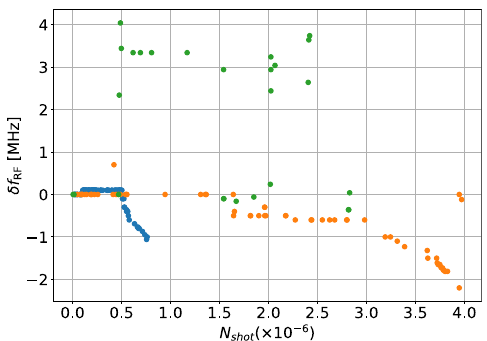
FIG. 5. The history of the pulse length, T p , during the high power test for three cavities, DAA2-1-uncoated (green), DAA2- 2-DLC (blue), and DAA2-3-DLC (orange). The horizontal axes denote the number of shots of rf pulse injected to each cavity with a repetition rate of 50 [Hz]. The vertical axes denote the pulse length, T p , of the injected rf pulse.